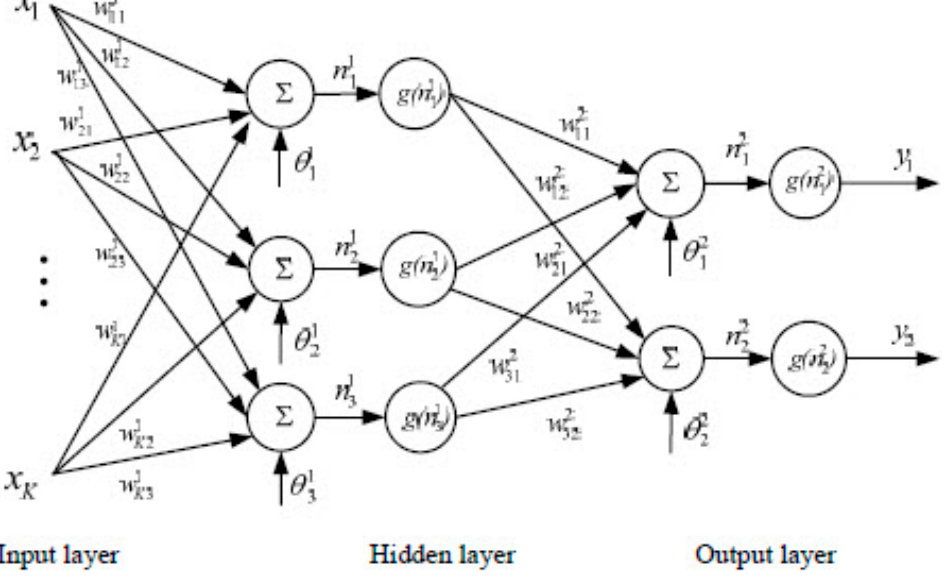
Figure 4. Artificial neural network node.